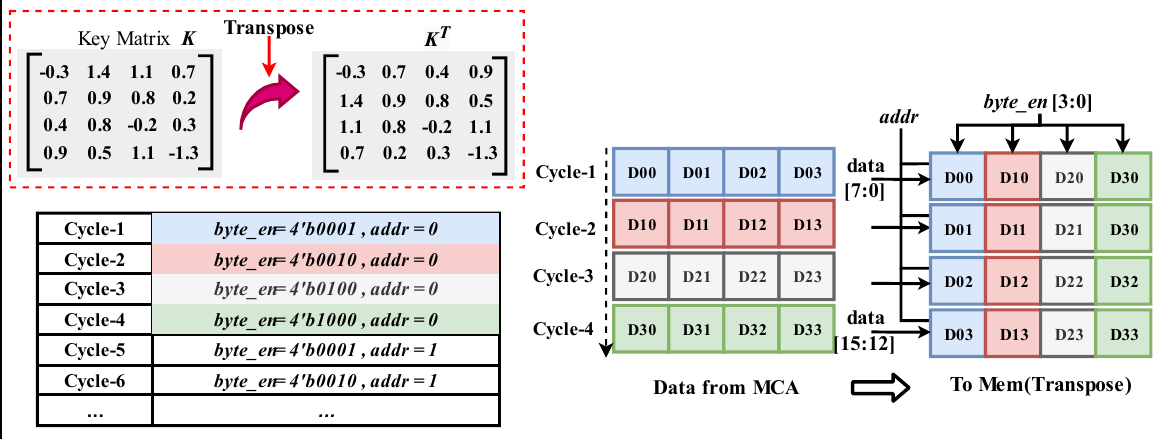
Figure 7. The schematic diagram of matrix transposition rearrangement.